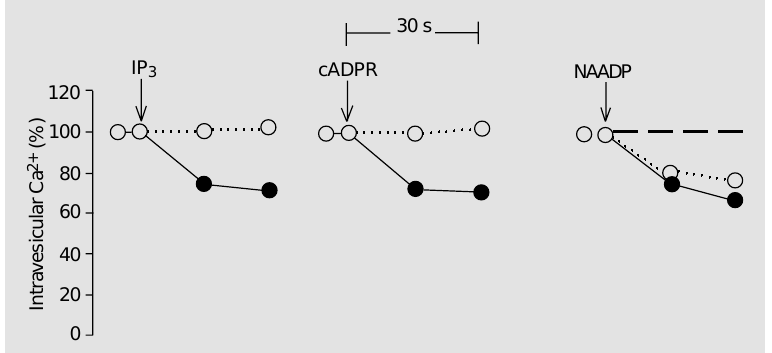
Figure 2. Ca 2+ release induced by nicotinic acid adenine dinucleotide phosphate (NAADP) from the thapsigargin-insensitive pool. The sea urchin egg homogenates were loaded with 45 Ca as described in Figure 1. After 3 h of Ca 2+ uptake, Ca 2+ release was initiated by addition of 1 µM IP 3 , 100 nM cyclic ADP-ribose (cADPR) or 100 nM NAADP. The Ca 2+ release was performed in homogenates loaded in the absence (open circles) or the presence (filled circles) of 10 µM thapsigargin.